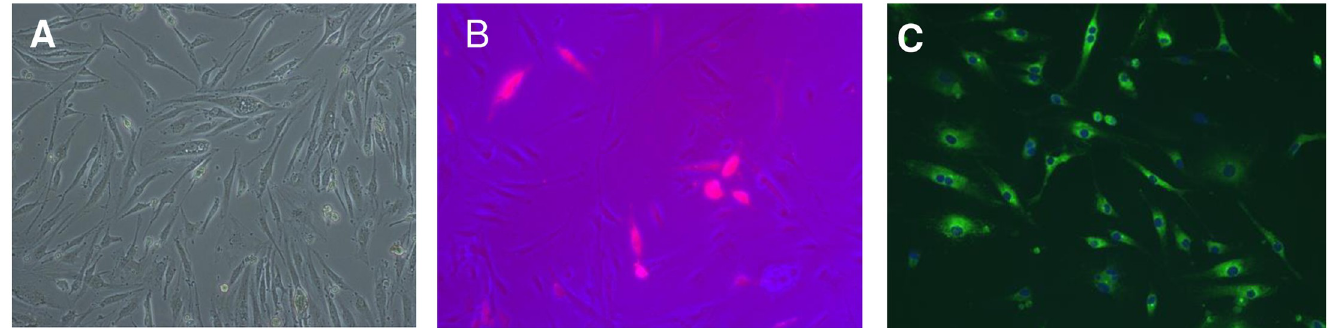
Fig 5. Successful transfection of elephant endothelial cells. A : Duncan P.1 umbilical cord primary endothelial cells. B: #1DuncanAMAXA P.4 endothelial cells expressing pMaxGFP. C: #1DuncanAMAXA cells at 105 days, immunostained for vonWillebrand Factor. Photos taken with an Olympus BX50, 20x original